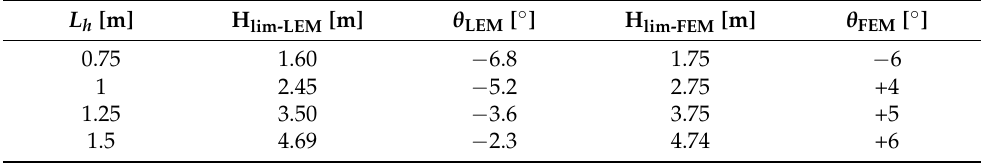
Table 1. Comparison between FEM and LEM limit hydraulic level for different values of L h .